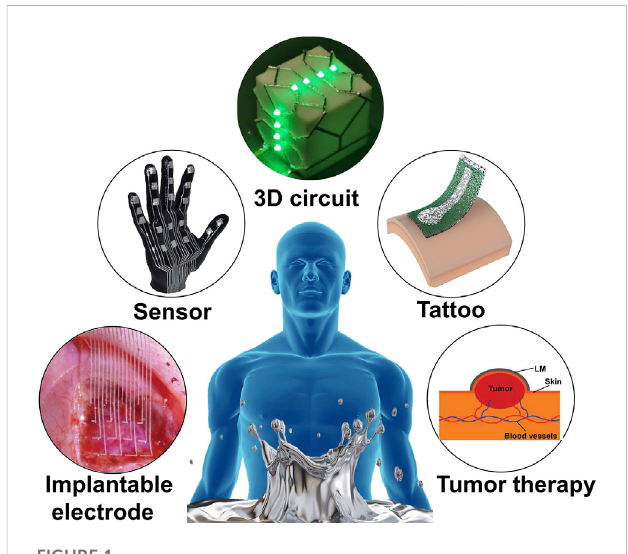
Various LM enabled conformal